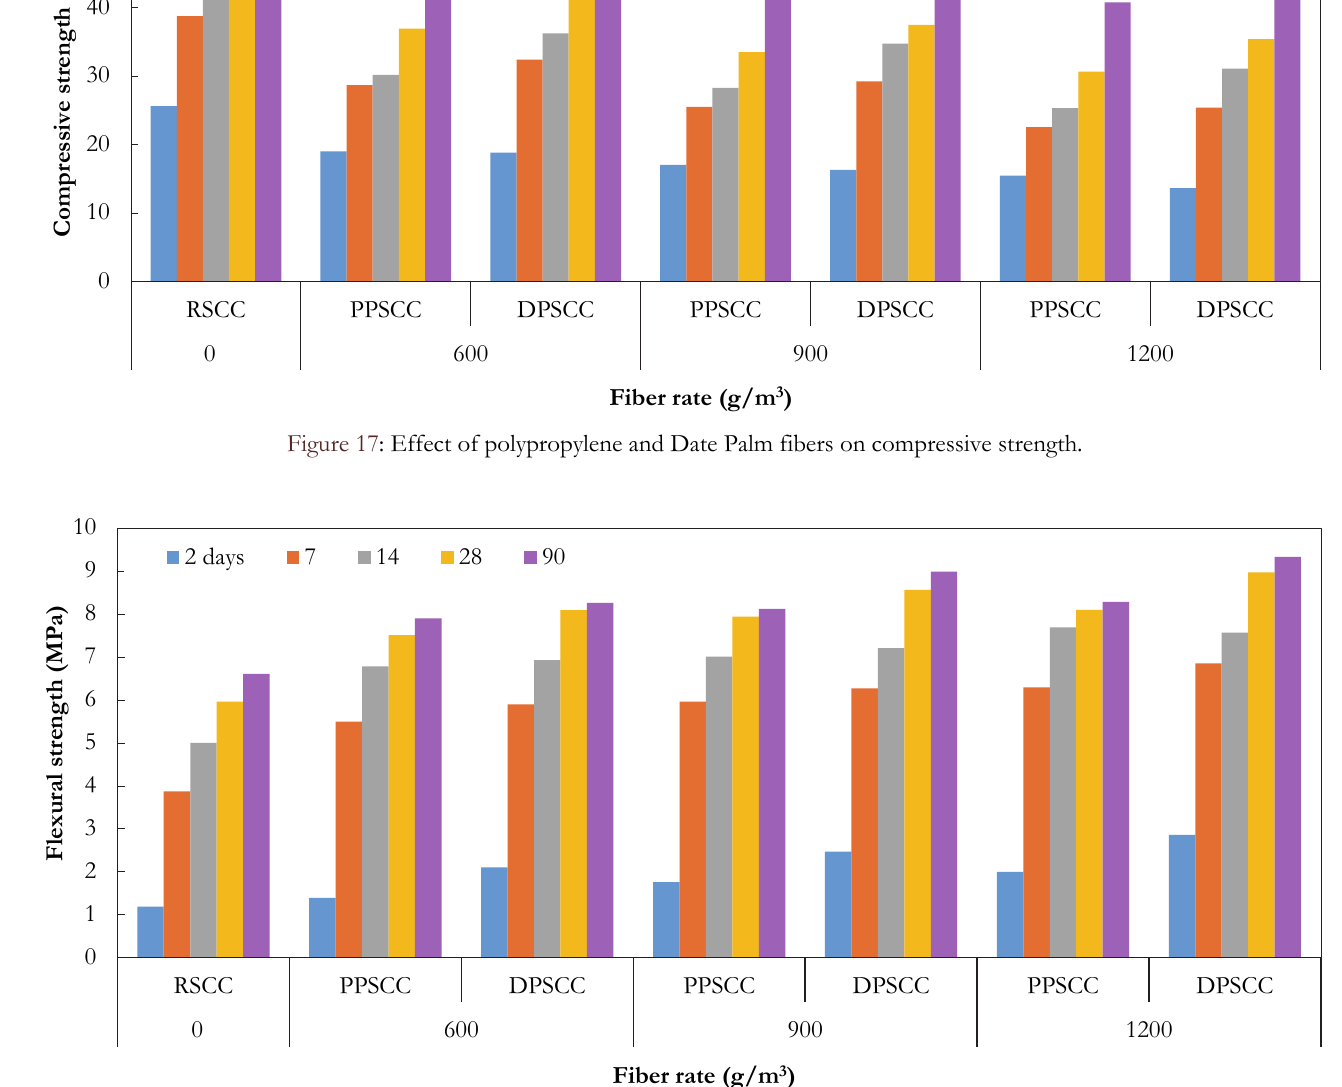
Figure 18: Effect of polypropylene and Date Palm fibers on flexural